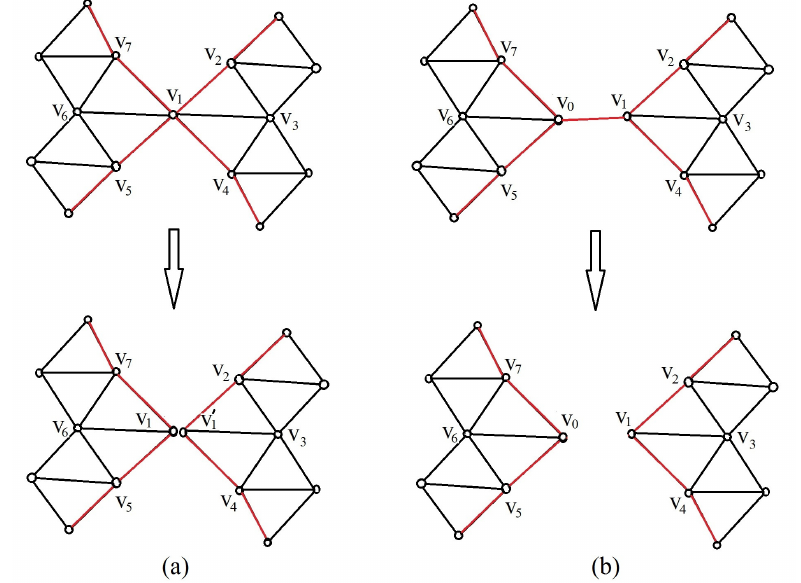
Figure 2. ( a ) Dangling vertex: Vertex v 1 belongs to two disconnected boundaries with boundary edges marked with red color. After vertex split, the two boundaries are merged into one. Now, a boundary vertex belongs to one boundary only. ( b ) Dangling edge: Edge e 01 belongs to two disconnected boundaries with boundary edges marked with red color. After edge removal, the two boundaries are merged into one. Now, a boundary edge belongs to one boundary and is adjacent with one